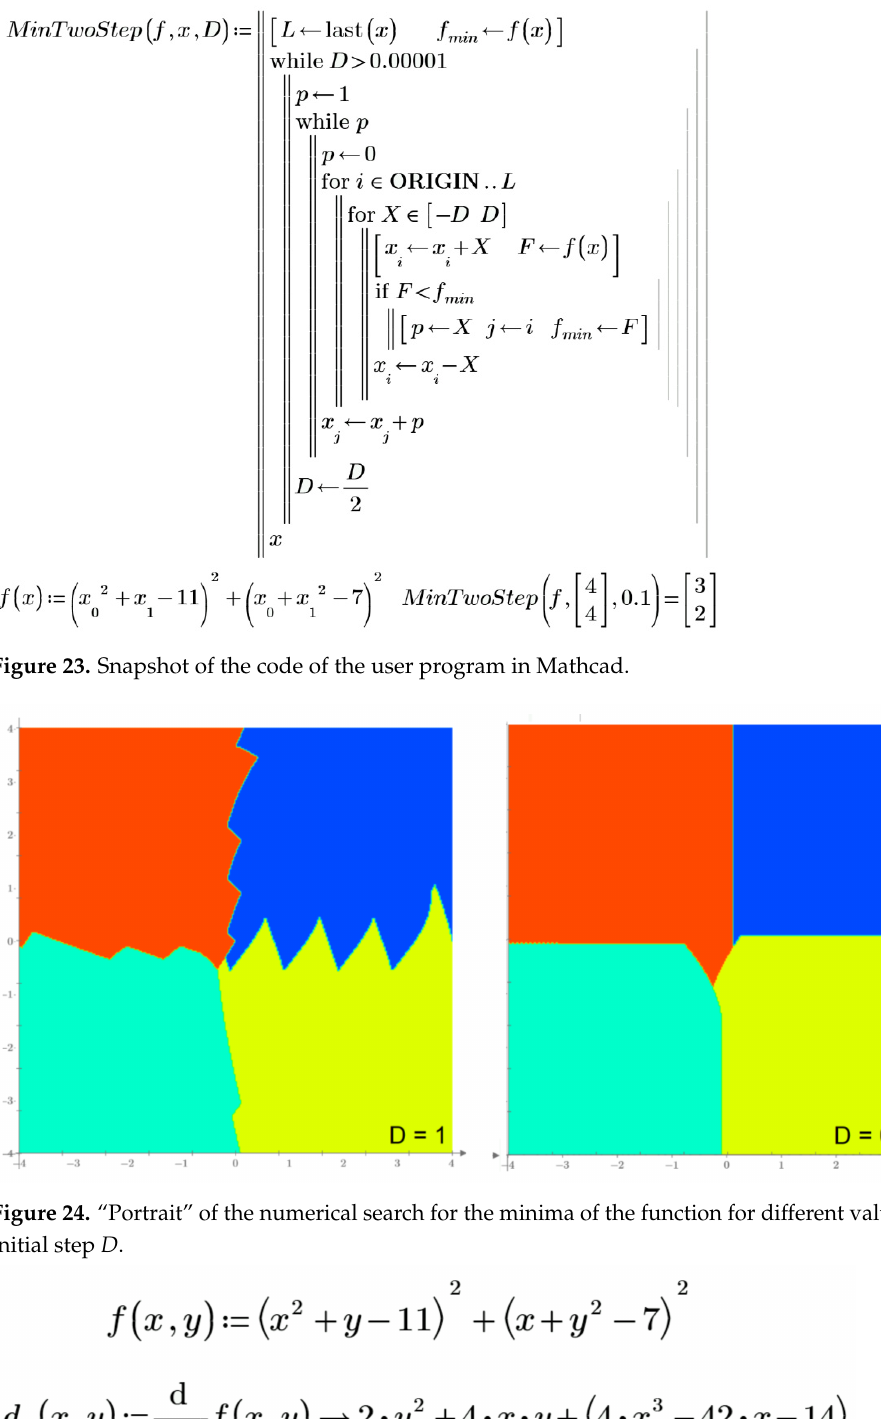
between the visualizations in Figures 10–12 with visualizations in Figures 20–22 and ask